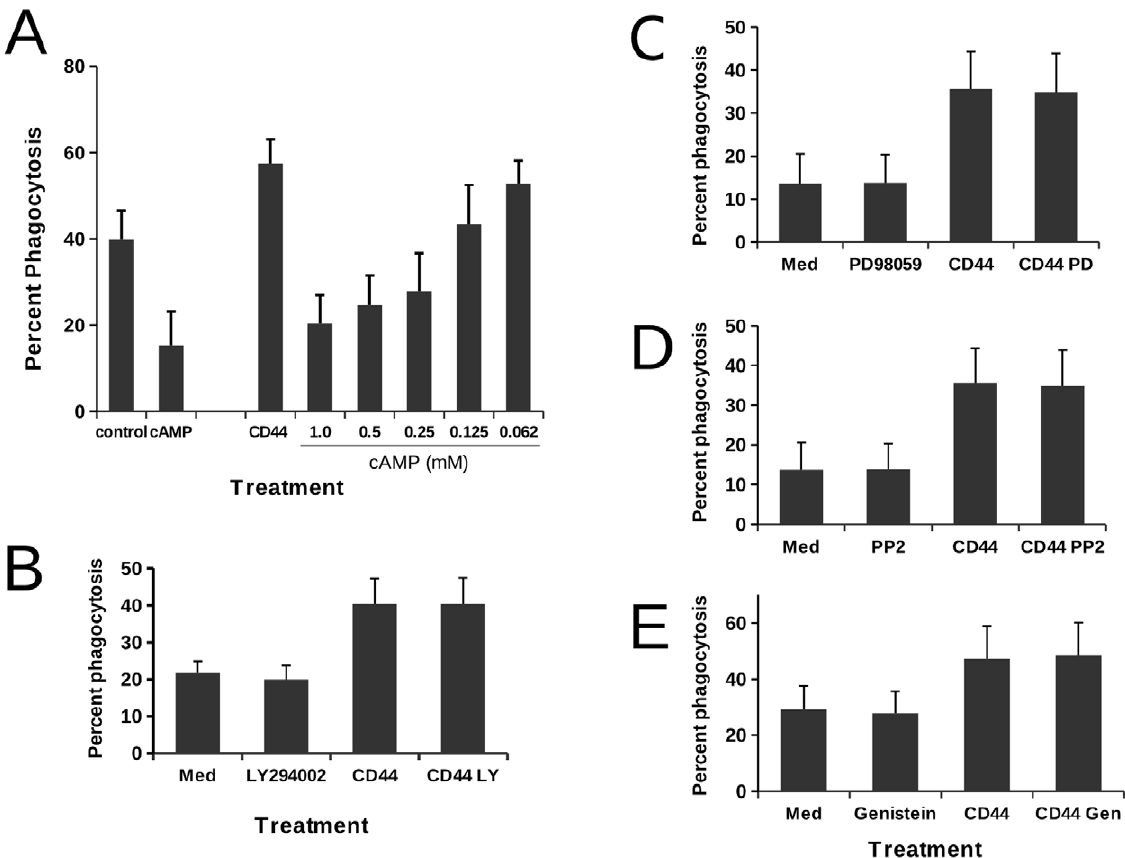
Figure 5. Effects of pharmacological inhibition of signalling pathways in macrophages upon CD44-augmentation of phagocytosis. A) Monocyte-derived macrophages were incubated with CD44 mAb for 30 min prior to addition of dibutyryl cAMP at concentrations shown. Macrophages were then co-incubated with apoptotic targets at 37 u C for 30 min prior to assessment of phagocytosis by microscopy. Results shown are mean percentage phagocytosis for 3 independent experiments. B) Monocyte-derived macrophages were pre-incubated with 10 m M LY294002 at 37 u C and then co-incubated with CD44 mAb for 30 min prior to addition of CMFDA-labelled apoptotic targets. After 30 min, assessment of phagocytosis was made by flow cytometry. Results shown are mean percentage phagocytosis 6 SEM for 5 independent experiments. C)Monocyte- derived macrophages were pre-incubated with 50 nM PD98059 at 37 u C and then co-incubated with CD44 mAb for 30 min prior to addition of CMFDA-labelled apoptotic targets. After 30 min, assessment of phagocytosis was made by flow cytometry. Results shown are mean percentage phagocytosis 6 SEM for 3 independent experiments. D) Monocyte-derived macrophages were pre-incubated with 25 m M PP2 at 37 u C and then co- incubated with CD44 mAb for 30 min prior to addition of CMFDA-labelled apoptotic targets. After 30 min, assessment of phagocytosis was made by flow cytometry. Results shown are mean percentage phagocytosis 6 SEM for 4 independent experiments. E) Monocyte-derived macrophages were pre-incubated with 25 m M Genistein at 37 u C and then co-incubated with CD44 mAb for 30 min prior to addition of CMFDA-labelled apoptotic targets. After 30 min, assessment of phagocytosis was made by flow cytometry. Results shown are mean percentage phagocytosis 6 SEM for 3 independent experiments. In panels B-E there was no statistical difference between the percentage phagocytosis recorded in the presence or absence of pharmacological inhibitor following CD44 mAb treatment.